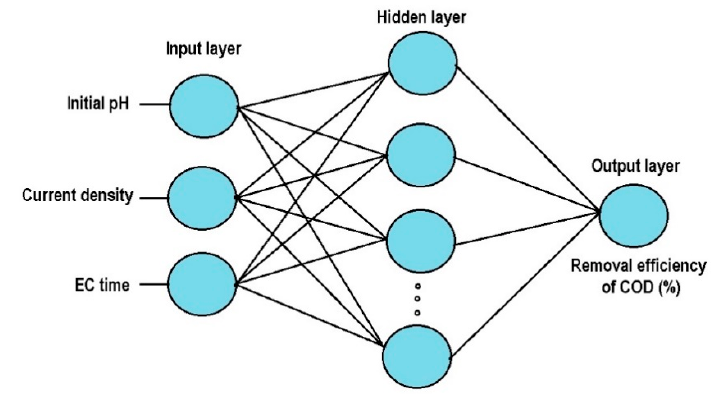
Figure 2. Schematic view of artificial neural network (ANN) model structure.